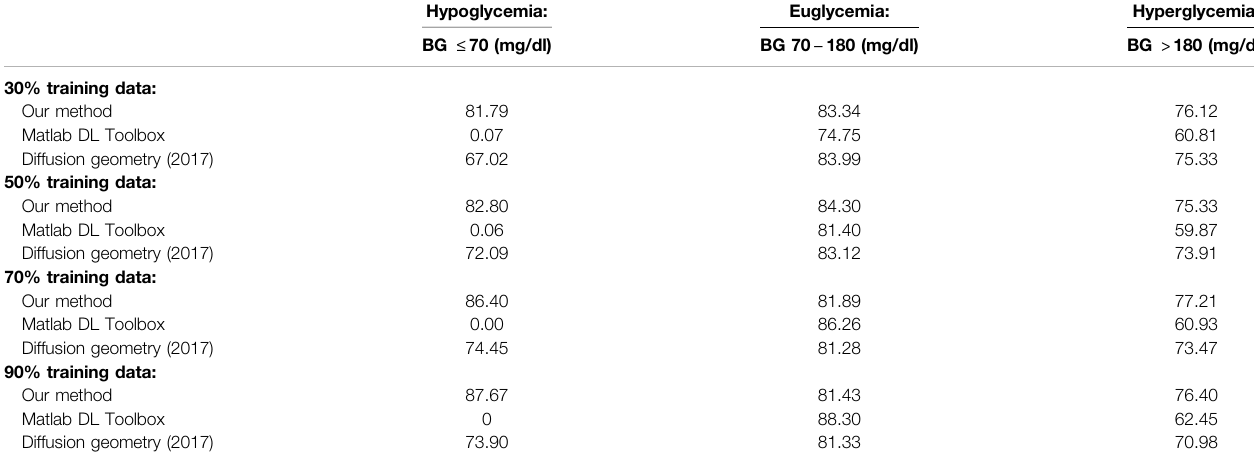
TABLE 6 | Percentage accurate predictions for different training set sizes and a 30 min prediction horizon on dataset J .